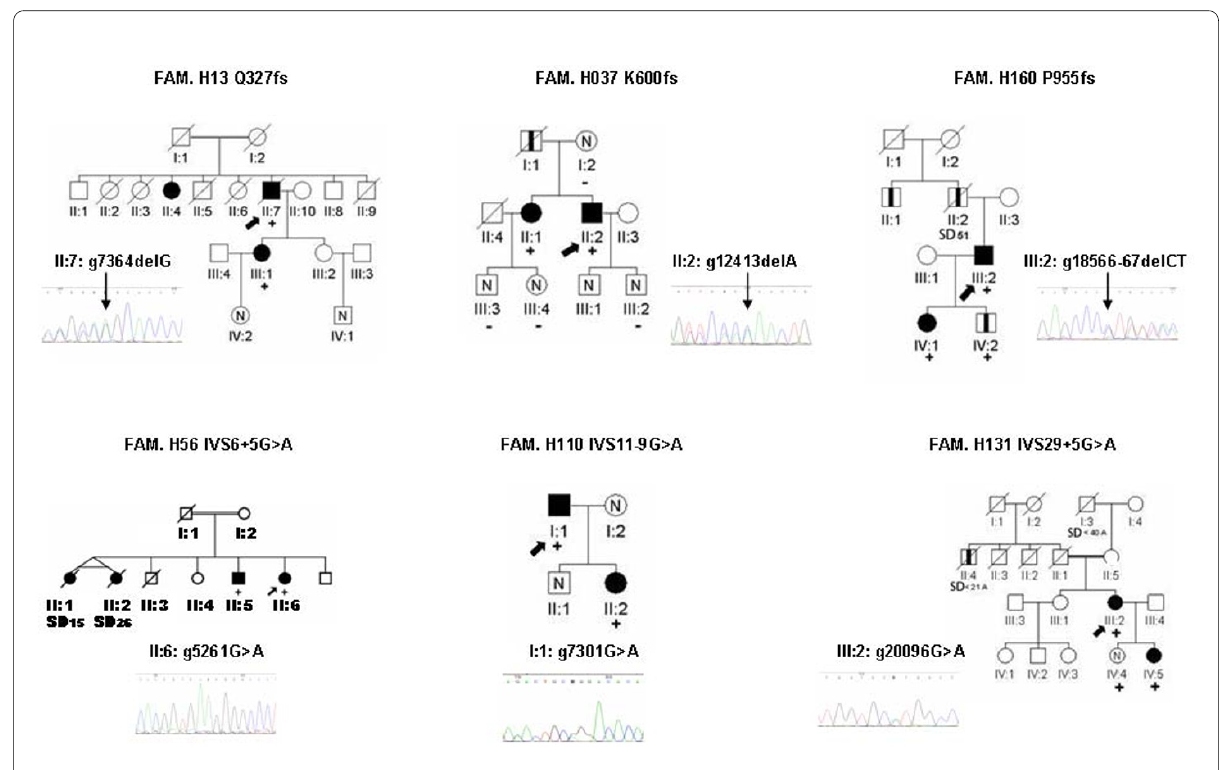
Figure 2 Pedigrees with the electropherogram of the frameshift and intronic mutations . Squares are males and circles are females. Filled in black are cases with HCM. Symbols with a black vertical bar represent relatives that were considered possibly affected. N means normal phenotype, empty symbols are non-evaluated relatives. The arrows indicate the index patients. Diagonal lines indicate deceased individual. + indicate carriers of the mutation and - indicates the non-carriers. SD means sudden